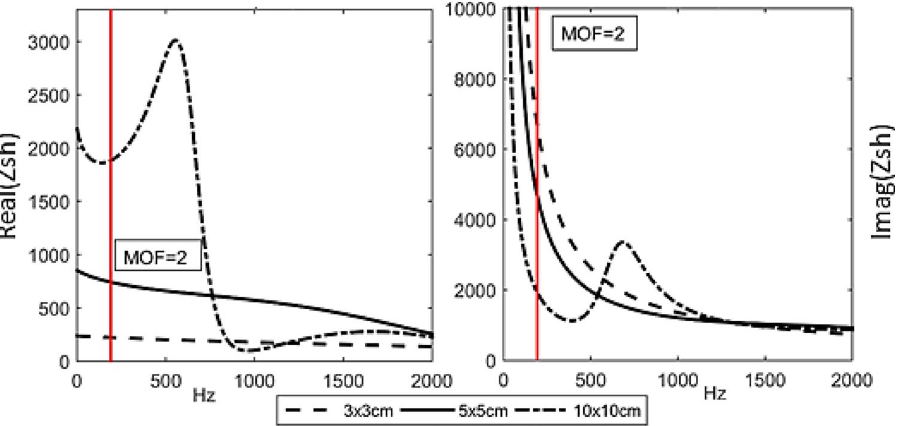
Figure 8. Real and imaginary values for the impedance of electrical shunt, Z sh using 3 × 3 cm, 5 × 5 cm and 10 × 10 cm patch. The red vertical line shows the frequency where MOF = 2.